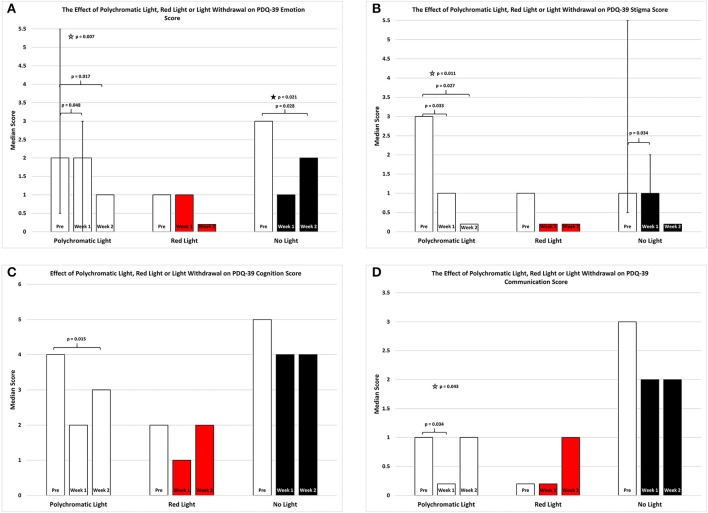
The effect of continued daily exposure to polychromatic light, red light or withdrawal of polychromatic light on the Emotion (A), Stigma (B), Cognition (C), and Communication (D) sub-sections of the PDQ-39 is expressed as the median score for each group after 3 assessments over a 2 week period. The pre-score served as the baseline and was obtained when the study commenced and before patients were randomly assigned to their respective treatment groups. The inclusion bars show significant statistical comparisons with p-values indicating the levels of significance obtained. Statistical comparisons were made between baseline (Pre) and Week 1, Pre and Week 2 and Week 1 and Week 2. Significant levels were determined a priori with a significant effect defined as p ≤ 0.05 while trends were designated as p values ranging from 0.051 to 0.099. The star represents a significant overall effect using the Friedman's Two Way ANOVA while the inclusion bars mark significant comparisons using the Wilcoxon Signed Rank Test. The T-bars represent first quartile and third quartile values. This provides a reference point whereby the range of values around the median serves to assist in visualizing the direction of change between medians in instances where median values were equal but significantly different.